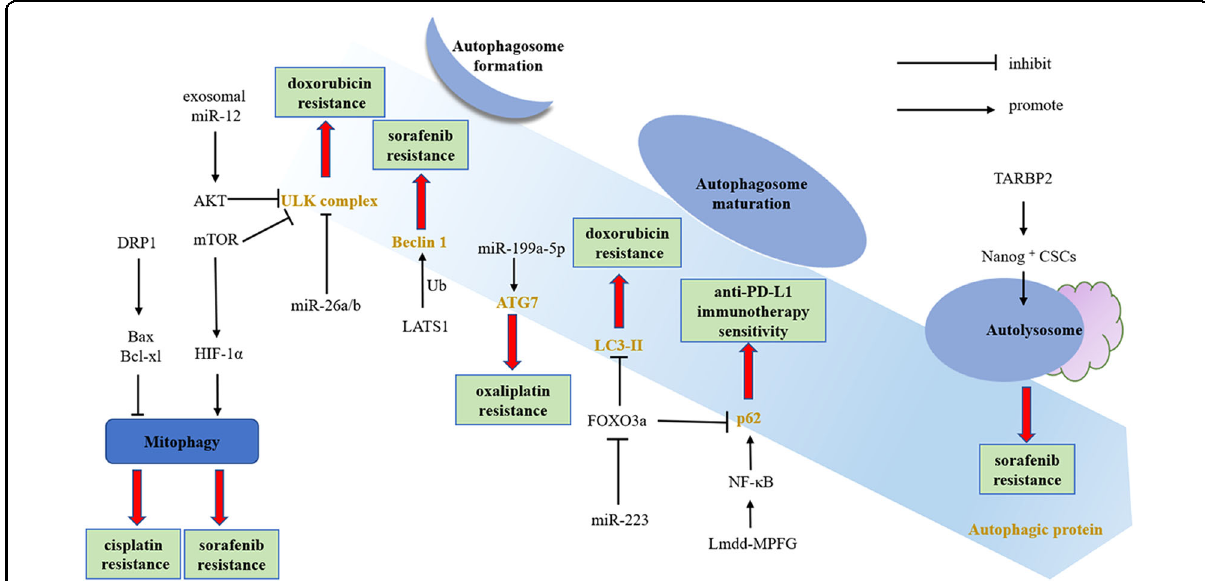
Fig. 3 Drug resistance and autophagy in HCC. The exosomal miR-12 regulates AKT to inhibit doxorubicin resistance. MiR-26a/b negatively regulates the ULK complex, inhibits autophagy, and reverses doxorubicin resistance. The expression of Beclin 1 is upregulated by sorafenib therapy, but Beclin 1 ubiquitinated by LATS1 inhibits autophagy, thereby promoting sorafenib resistance. HIF-1 α regulates mitophagy to promote sorafenib and cisplatin resistance. The high expression of miR-223 downregulated the expression of FOXO3a, inhibits autophagy levels through LC3 and p62, and promotes doxorubicin resistance. Activation of NF- κ B induces autophagy by regulating the level of p62 and enhances the sensitivity of anti-PD- L1 immunotherapy. DRP1 inhibits mitophagy through Bax and Bcl-xl and reverses the occurrence of cisplatin resistance. TARBP promotes the expression of stemness marker Nanog in CSCs, facilitates the fusion of lysosomes and autophagosomes, and promotes sorafenib